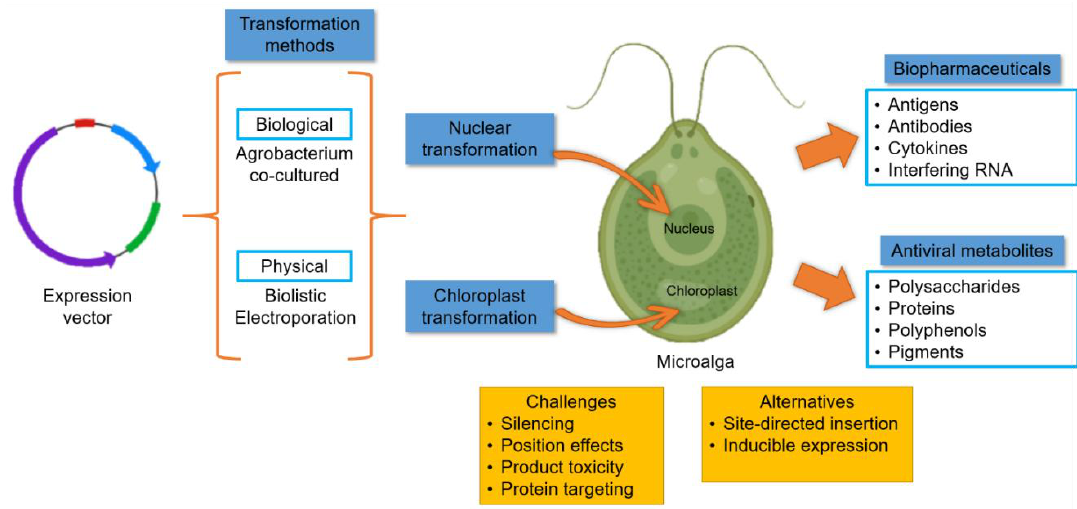
Figure 2. Genetic engineering in algae. Algae can be genetically engineered to improve the production of native antiviral compounds or introduce the biosynthetic pathway for those not produced in algae; moreover, they can be used as biofactories of biopharmaceuticals. The genomes at the nucleus and chloroplast can be engineered with specific genes to achieve the desired trait. The main challenges are genetic instability and low expression often observed in the transformed strains, which can be overcome by using site-directed insertion of the foreign DNA, inducible promoters, and optimized regulatory sequences.